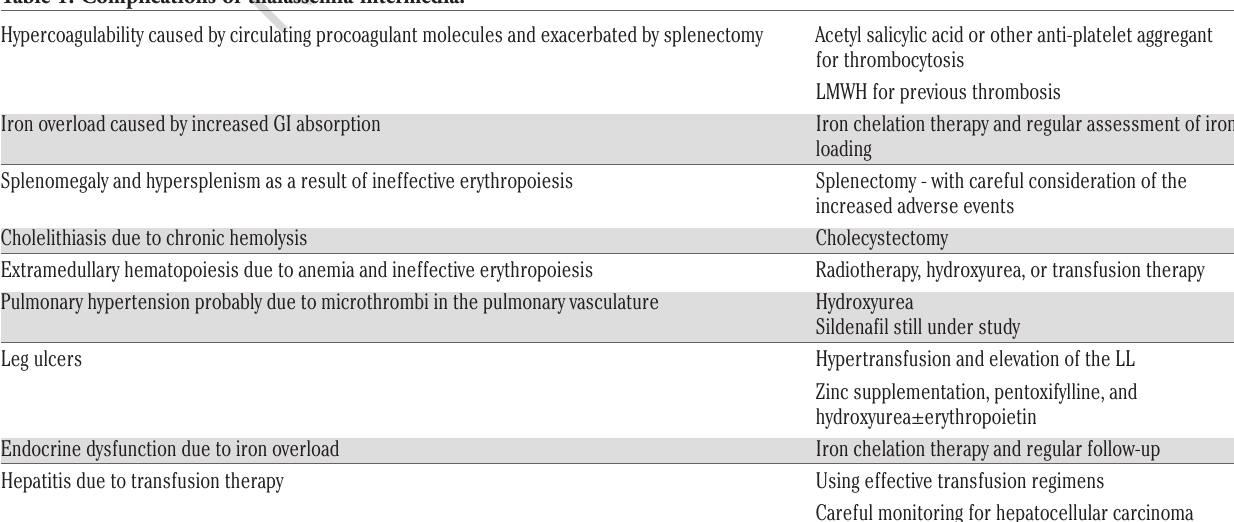
Table 1. Complications of thalassemia